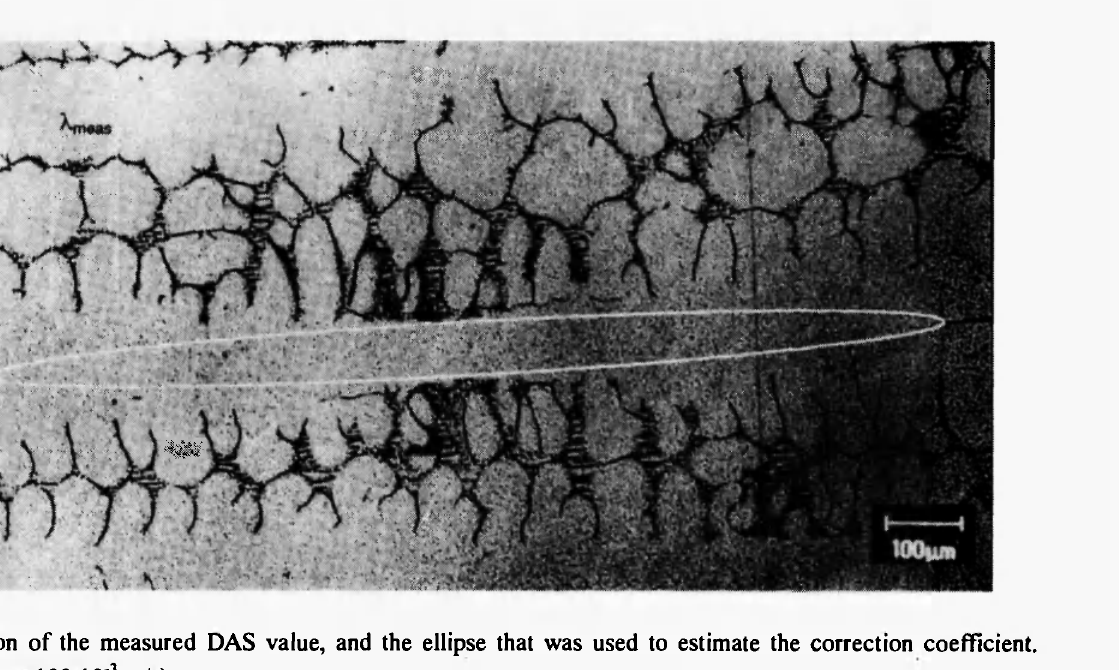
Fig. 8: Definition of the measured DAS value, and the ellipse that was used to estimate the correction coefficient. (IN625 - v=10010" 3